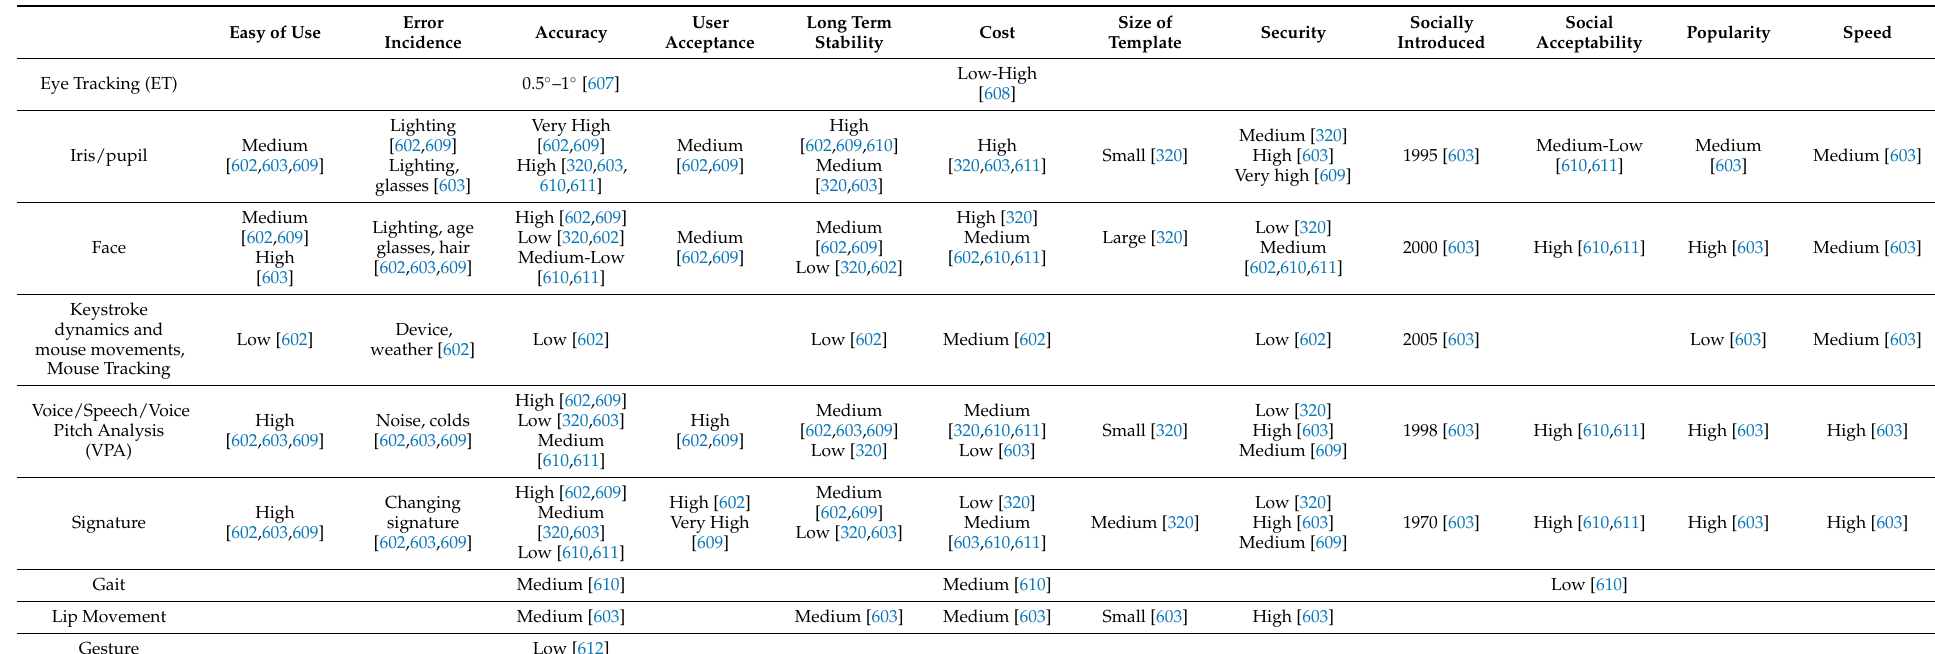
Table 11. Comparison of biometric technologies by various